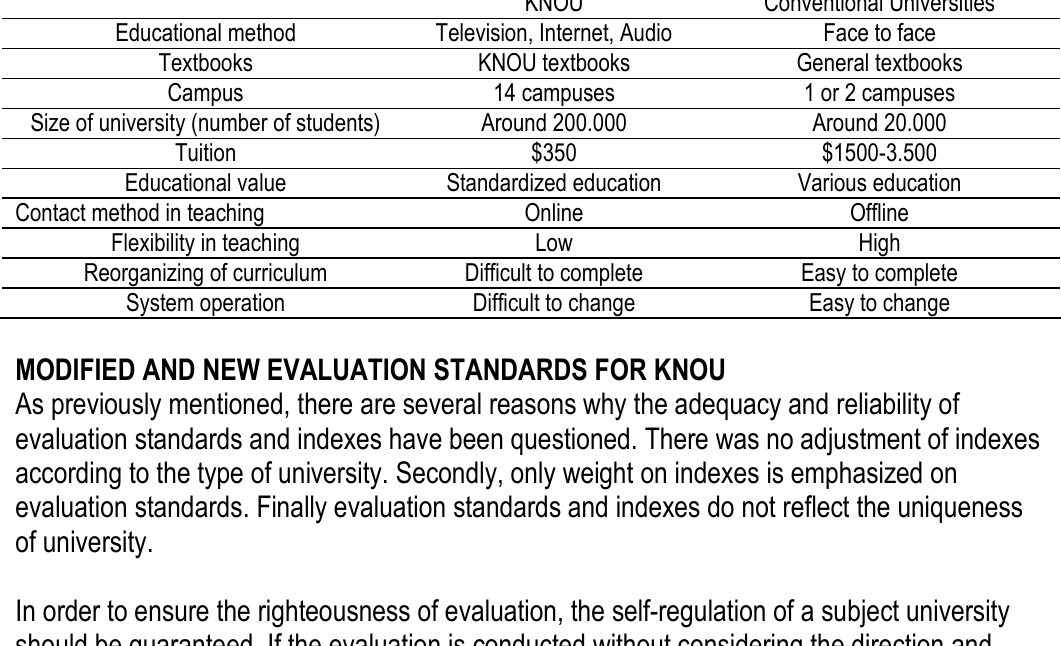
Table 3. Comparison of KNOU with conventional universities